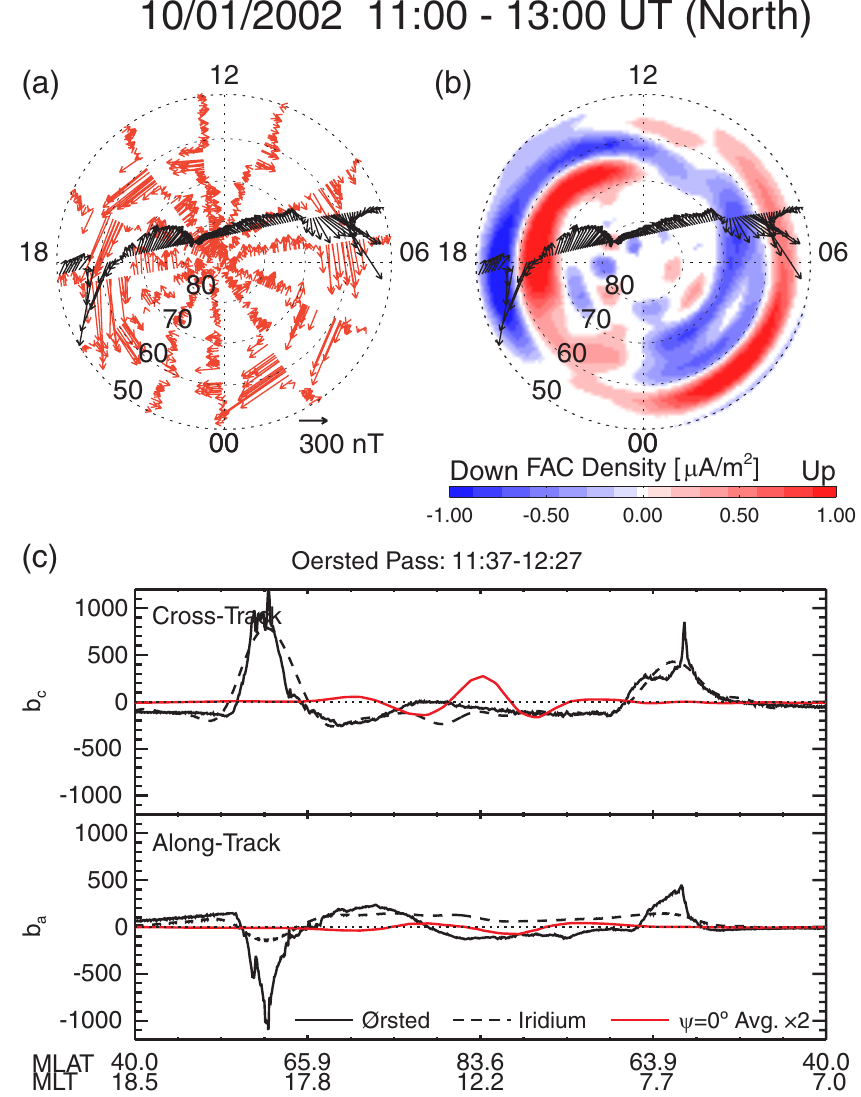
Fig. 9. Ørsted and Iridium observations for a southward IMF event from 1 October 2002 in the same format as Fig. 6. Iridium data are from 11:00 to 13:00UT and Ørsted data are from the Northern Hemisphere pass from 11:37 to 12:27UT. The red traces in panel (c) are the ψ = 0 Iridium statistical result evaluated along the Ørsted track multiplied by two and are shown to indicate the signatures that would have been anticipated for NBZ-like polar cap currents. Average solar wind and IMF conditions for this interval are given in Table 3.